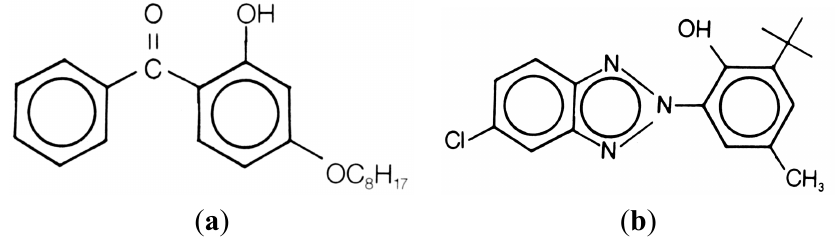
Figure 5. Chemical structures of typical ( a ) benzophenone and ( b ) benzotriazole UV absorbers used to photostabilize clear coatings and